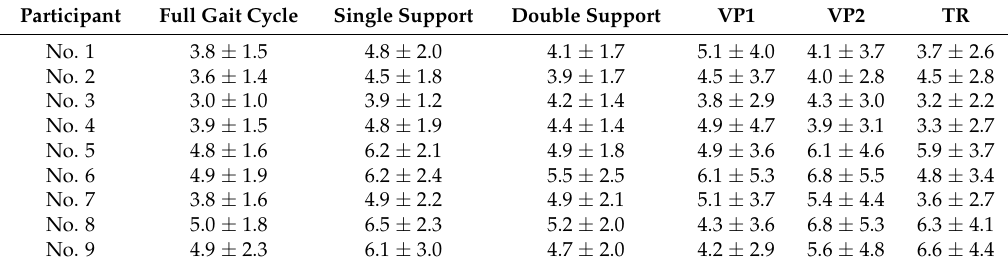
Table 6. Mean and SD of prediction errors for OCW (rRMSE %) based on forehead (FH) acceleration.